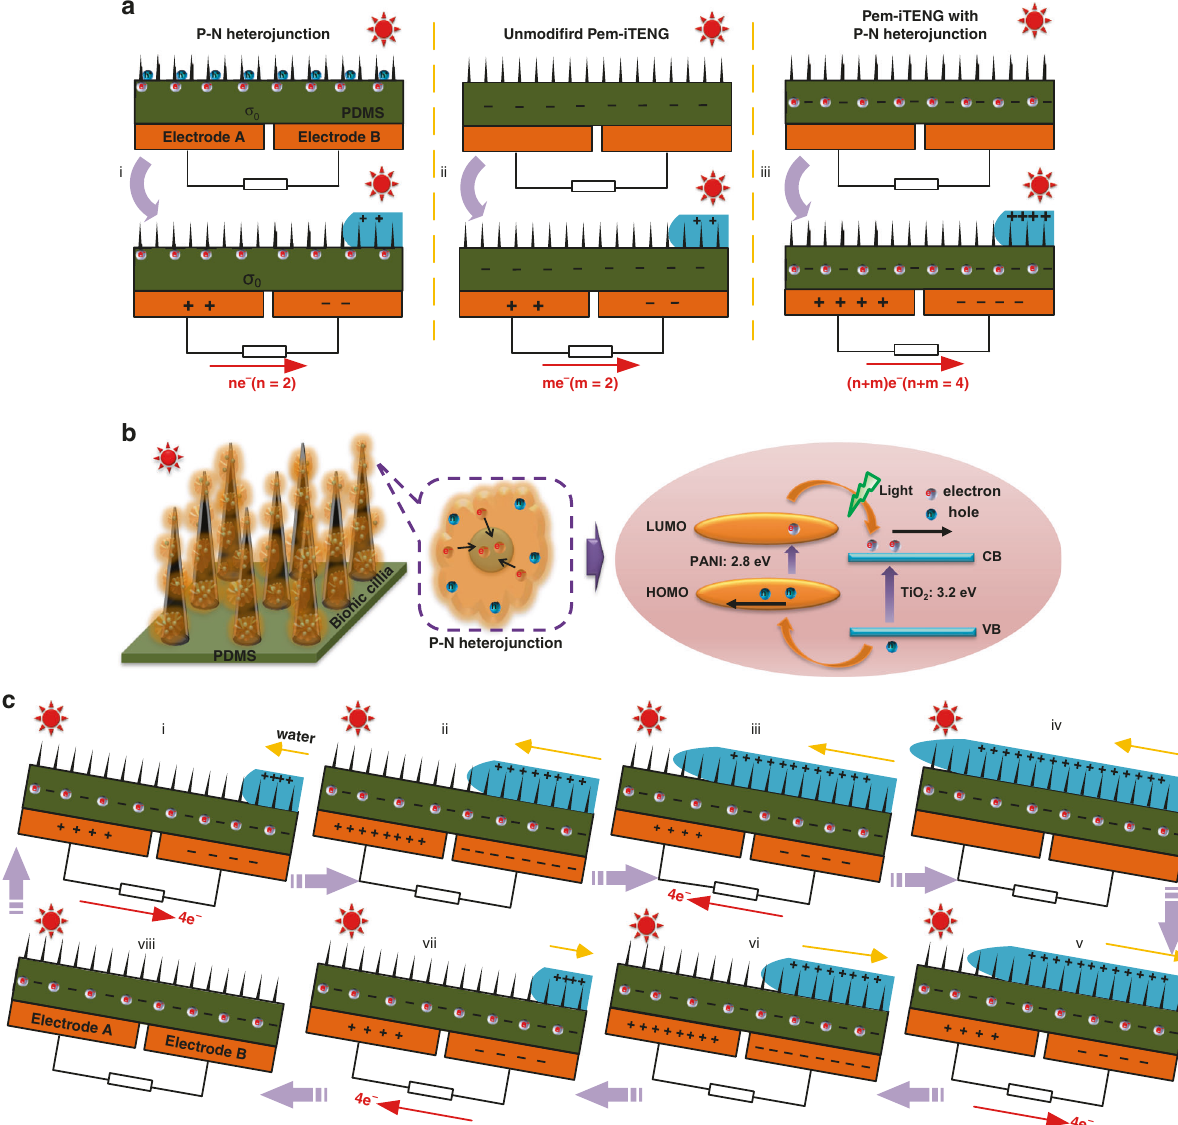
Fig. 1 The working principles of Pem-iTENG. a Pem-iTENG with P-N heterojunction (i). Unmodi fi ed and modi fi ed Pem-iTENG during the two fl ow states of the tidal waves (ii and iii). b Principles of photocatalysis of bionic cilia with a P-N heterojunction. c The contact electri fi cation of Pem-iTENG in a cycle of reciprocating tidal waves and free electron transfer direction between the two